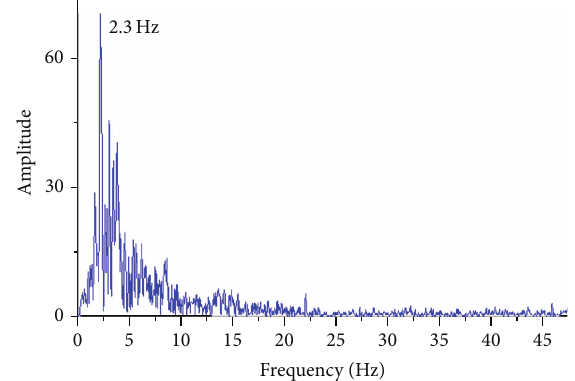
spandrel is calculated [18, 21]; and according to the models parameters, results are calculated as shown in Tables 3 and